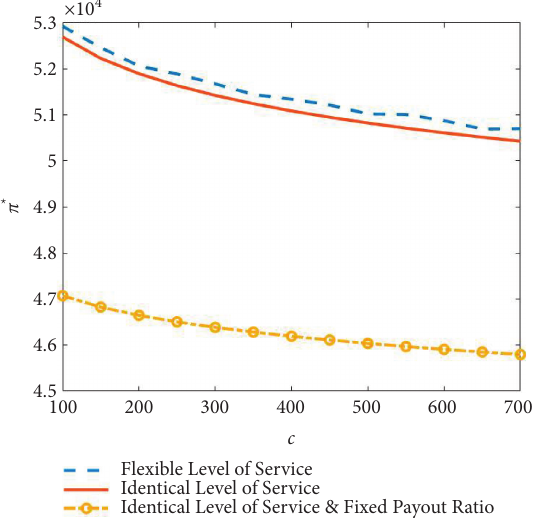
Figure 12: Sensitivity analysis of π ∗ in terms of c